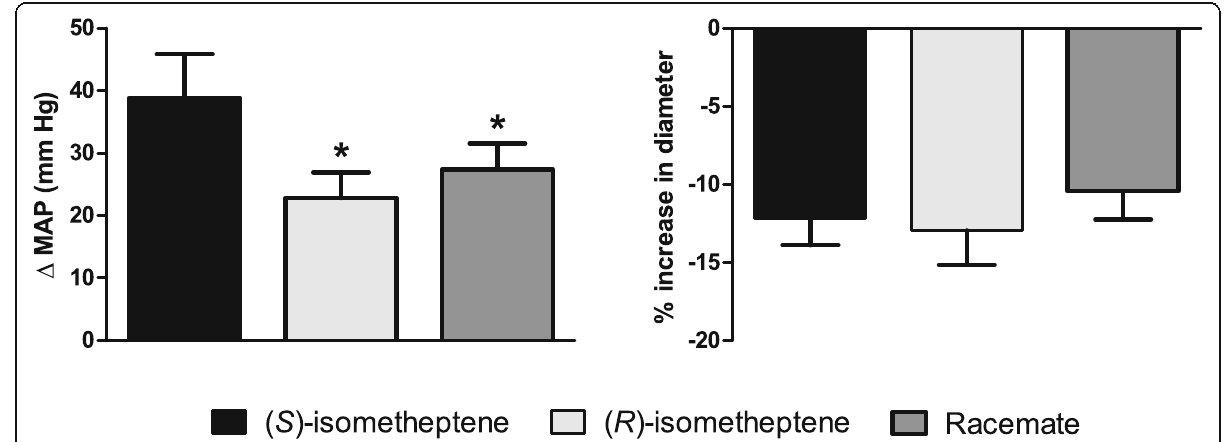
Fig. 2 Effect per se of i.v. bolus injections of ( S )-isometheptene, ( R )-isometheptene and the racemate (3mg/kg each) on mean arterial pressure (MAP) and dural artery diameter; all compounds produced significant vasopressor responses and dural vasoconstriction ( P <0.05); * p <0.05 as compared to ( S